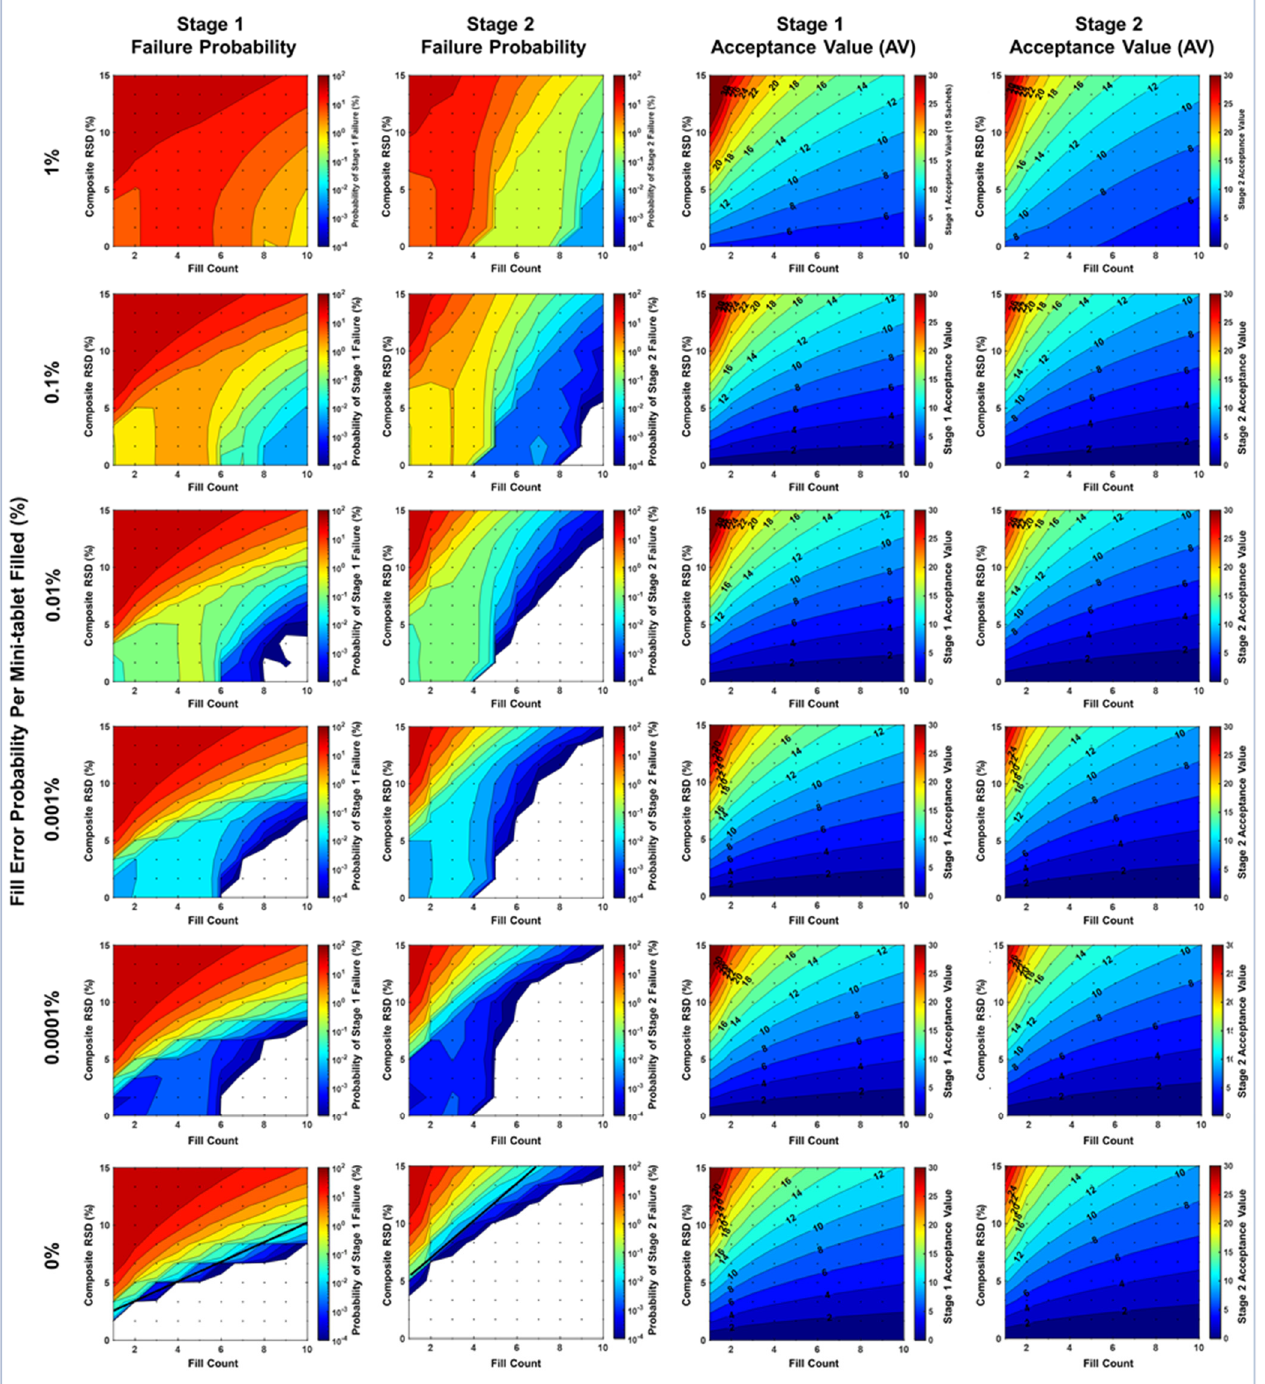
Figure 5. The probability of stage 1 and stage 2 content uniformity batch failure and acceptance values (AV) modeled as a function of sachet fill count (horizontal axes), composite RSD of bulk mini-tablets (vertical axes), and fill error probability per mini-tablet filled (rows). Tabulated values may be found in Supplementary Materials Section S2.2.